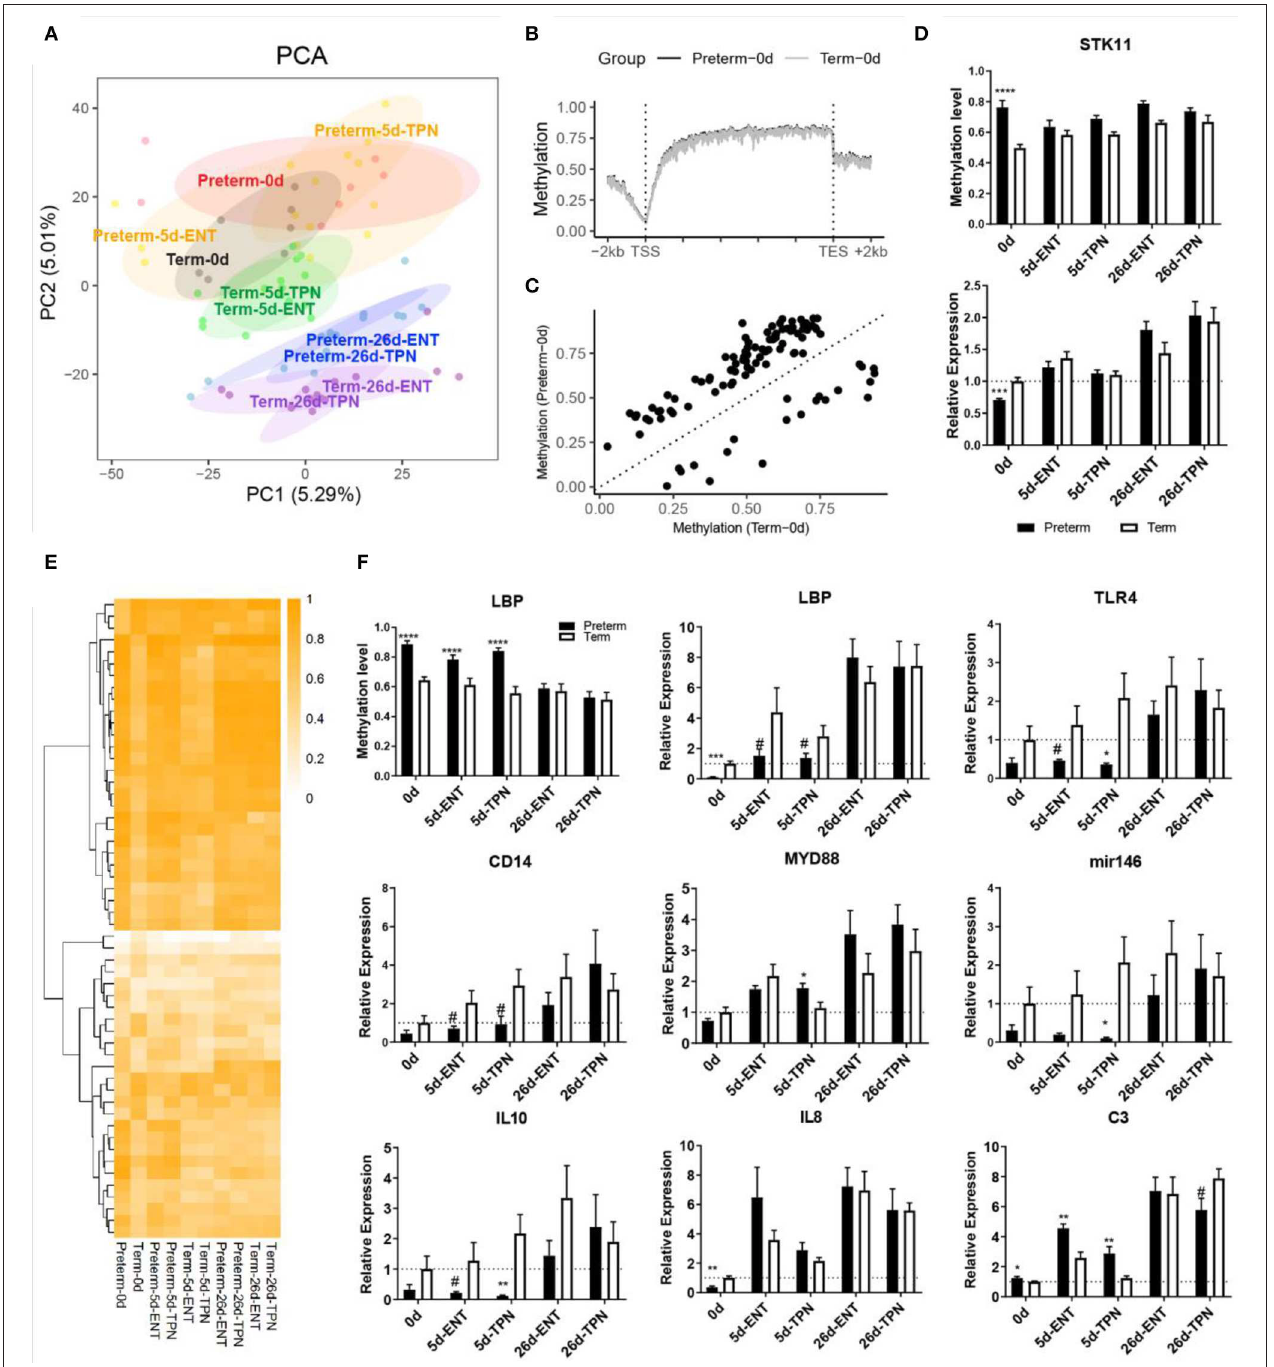
FIGURE 2 | DNA methylation and gene expression difference at birth and their postnatal changes. (A) Scores of first two principle components from PCA are plotted, with ellipses for the 80% confidence interval for each group. Pigs with the same age after either preterm or term delivery are labeled with the same colors. (B) Birth DNA methylation levels along the gene bodies and 2-kb upstream of the TSS and 2-kb downstream of the TES of all Ensembl genes. (C) Scatterplot showing mean methylation level of DMRs in preterm and term pigs at birth. (D) Barplot showing promoter methylation level and mRNA expression of STK11. (E) Heatmap depicting methylation level of birth DMRs in postnatal period. Hierarchical clustering was performed using complete linkage method with euclidean distance. (F) Barplot showing promoter methylation level and mRNA expression of LBP, and mRNA expression of immunity-related genes. Values in barplots are presented as mean ± SEM. # P < 0.1, * P < 0.05, ** P < 0.01, *** P < 0.001, **** P < 0.0001.